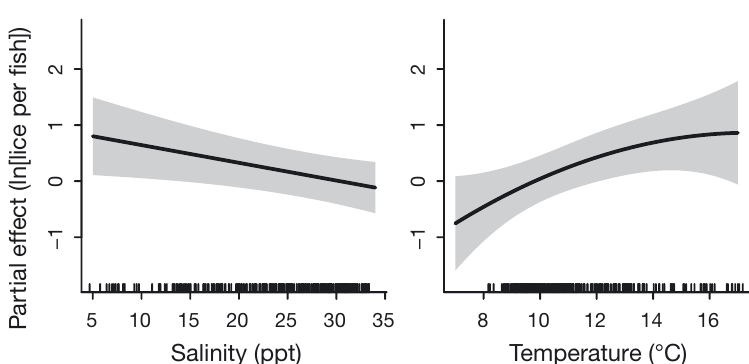
Fig. 9. Estimated additive effects of salinity and temperature on ln(lice per fish) when fitted only on data from 2018 ‒ 2020. The figure shows partial effects with 95% pointwise confidence bands. The model also includes infestation pressure as a covariate, which assumes temperature-dependent production of lice larvae and temperature- and salinity-dependent infectivity. Tick marks on the x -axes show the locations of the